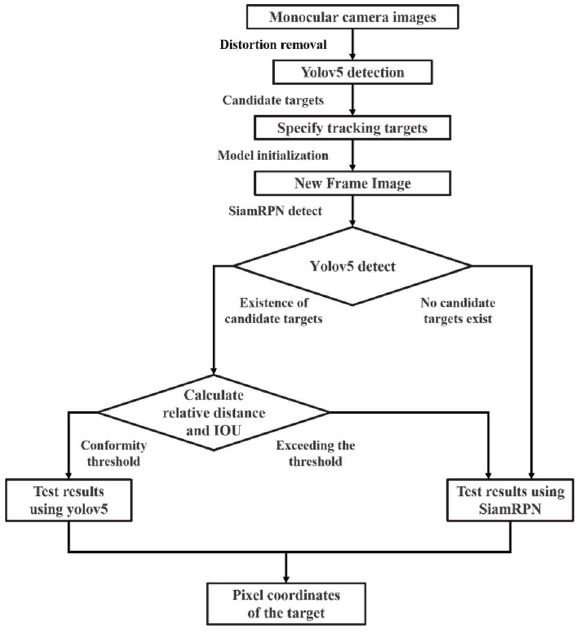
Figure 5. DTAT method structure.